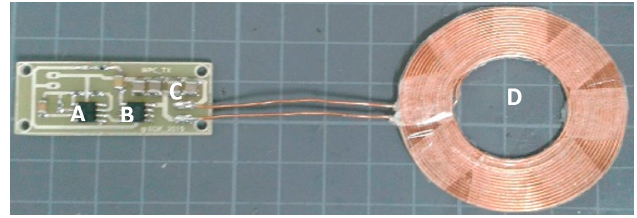
Figure 12. Wireless power transmitter apparatus prototype. Part A is a DC–DC converter and a high frequency generator, part B is a power amplifier, part C is an oscillator and part D is a transmitter coil.